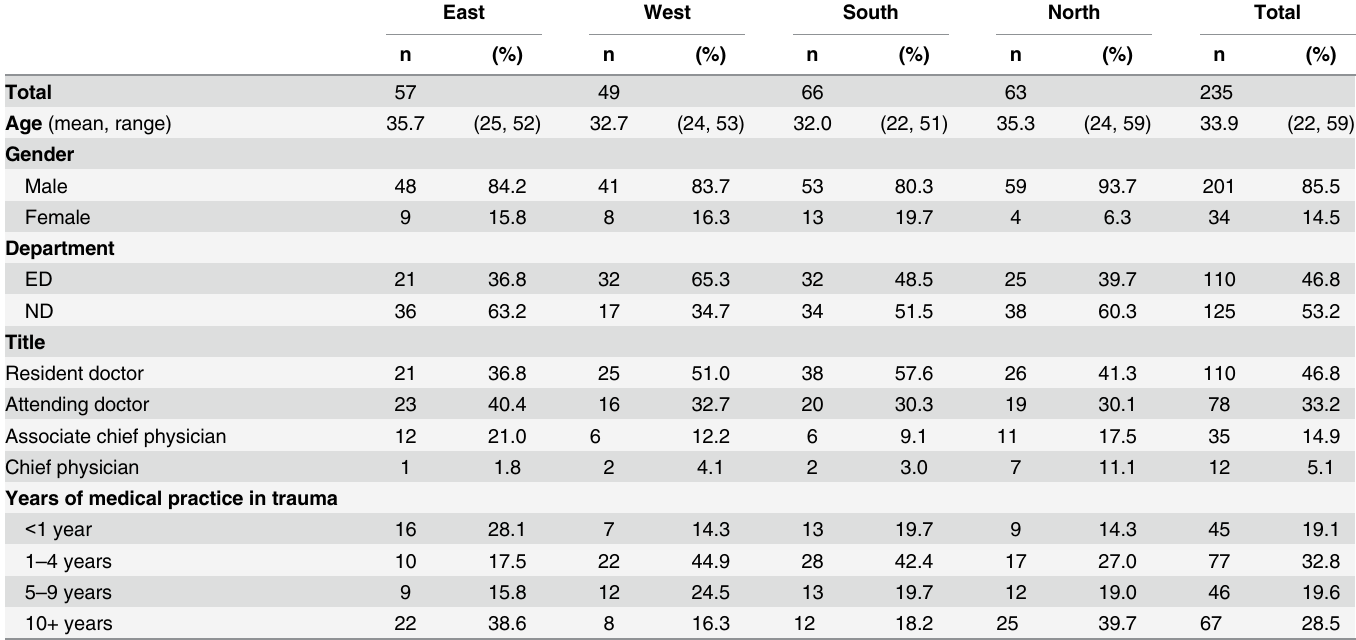
Table 1. Demographic Information of Surveyed ED and ND Clinicians from 9 Large Hospitals in